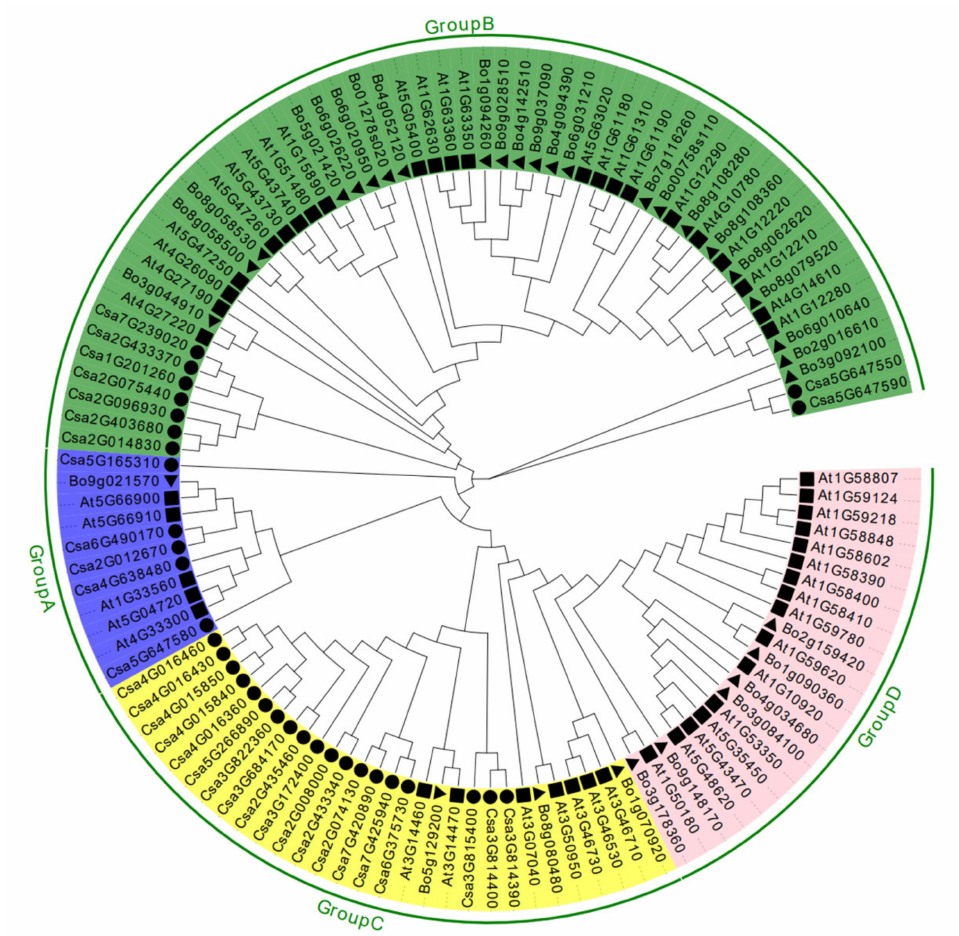
Figure 2. Phylogenetic relationships of CNL proteins among cucumber, cabbage and Arabidopsis . The unrooted phylogenetic tree was constructed by MEGA7.0 by neighbor-joining method with 1000 bootstrap replicates. The CNLs are divided into four major subfamilies. Different subfamily was indicated with different colors. The black triangles represented cabbage, black squares represented Arabidopsis , and black circles represented